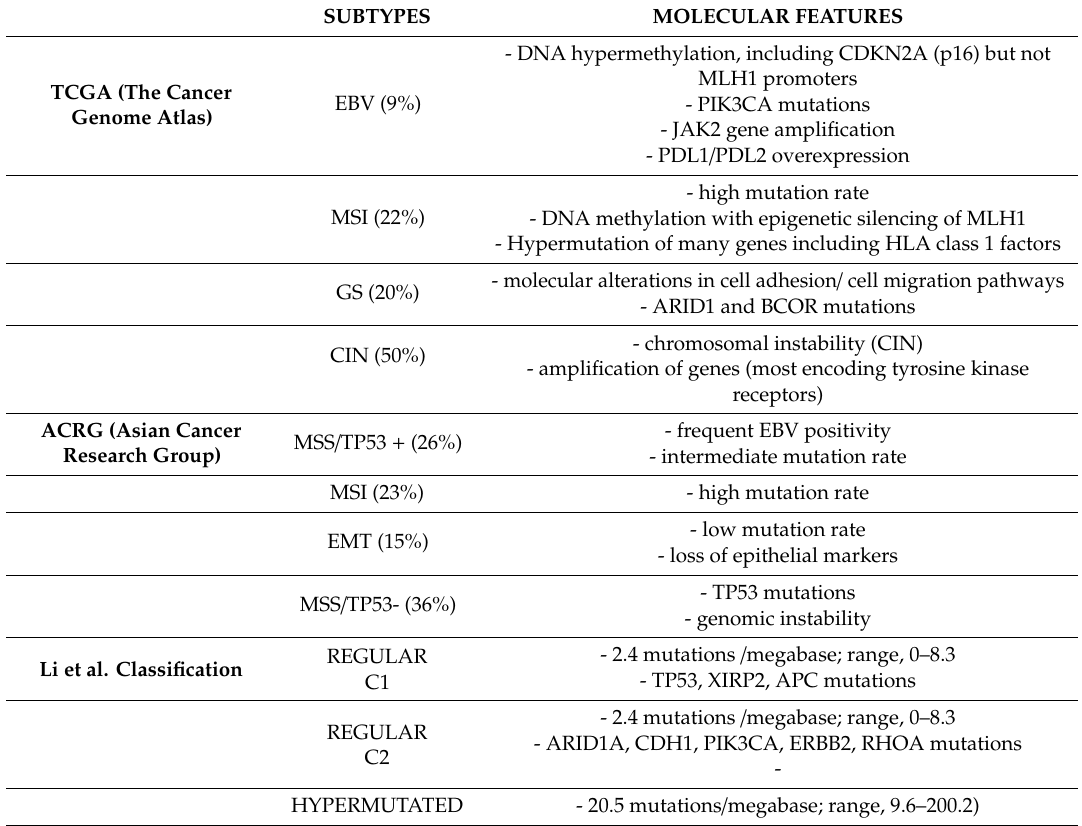
Table 1. Molecular classification of Gastric Cancer according TCGA (The Cancer Genome Atlas)emt; ACRG (Asian Cancer Research Group) and Li et al.